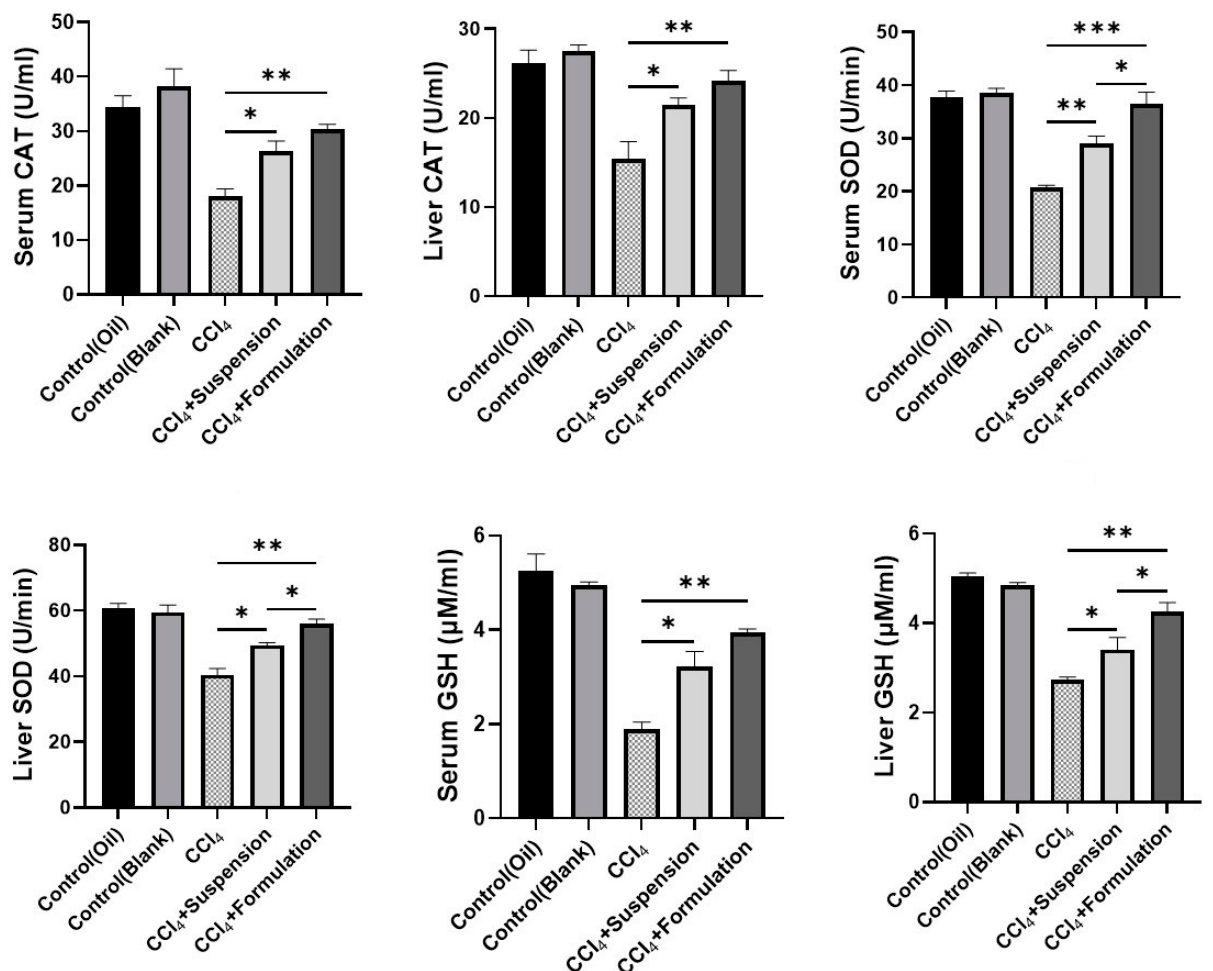
Figure 8. Effects of B. lacera leaf extract and its liposomal preparation on liver antioxidant enzymes. Data are presented as mean ± SEM, n = 6. where * p ≤ 0.05, ** p ≤ 0.01, *** p ≤ 0.001, when compared between the CCl 4 , CCl 4 + suspension and CCl 4 + formulation (liposomal) groups. p ≤ 0.05 was considered the statistical level of significance for all cases. CAT: Catalase, GSH: Glutathione, SOD: Superoxide dismutase.